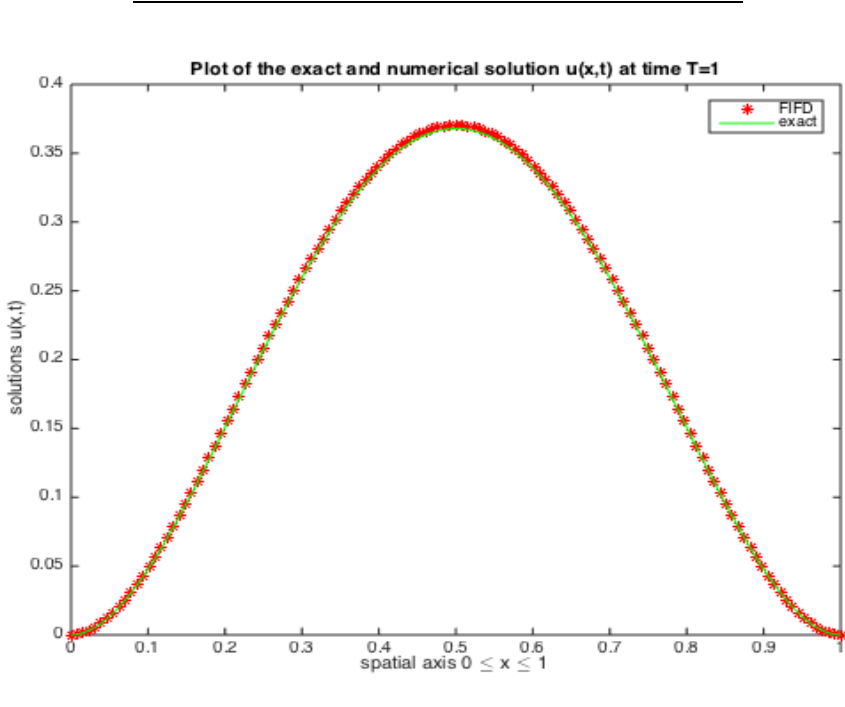
Figure 1. The true solution u (marked by “—”), the fast iterative finite difference solution u (marked by “ ∗ ”), in §4 at time T = 1 with h = 1 FIFD